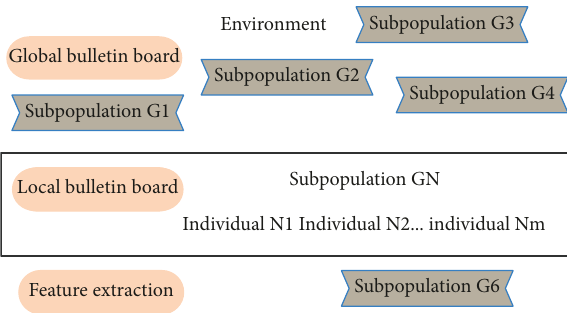
Figure 5: :Schematic diagram of the structure of the